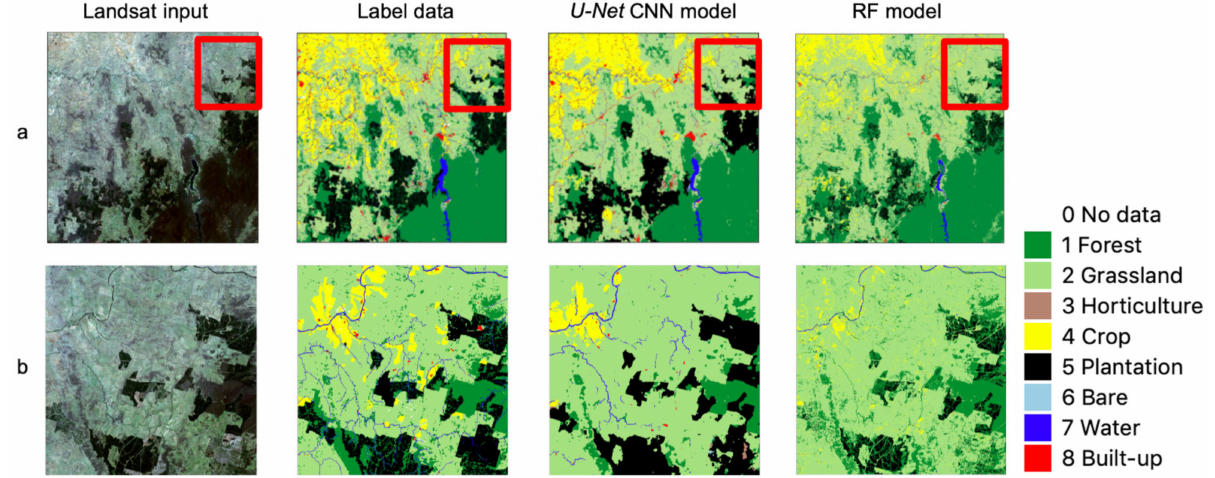
Figure 6. ( a ) Landsat input (true colour RGB), label data and model results for tile +14, − 40 (~100 km × 100 km). ( b ) An area of tile +14, − 40 surrounding the locality of Adjungbilly (box in ( a